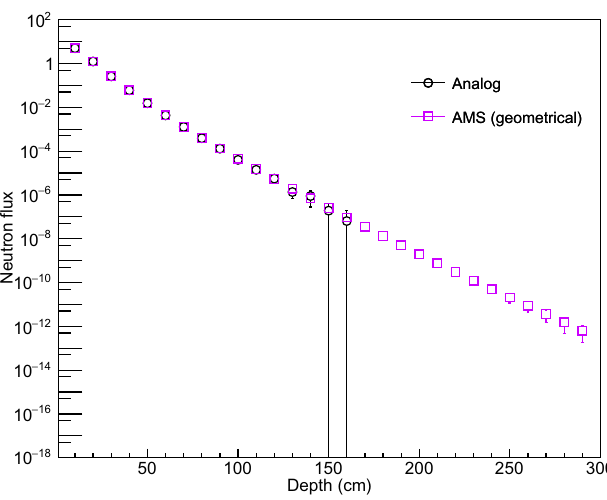
Fig. 4. Flux attenuation in the Water box.